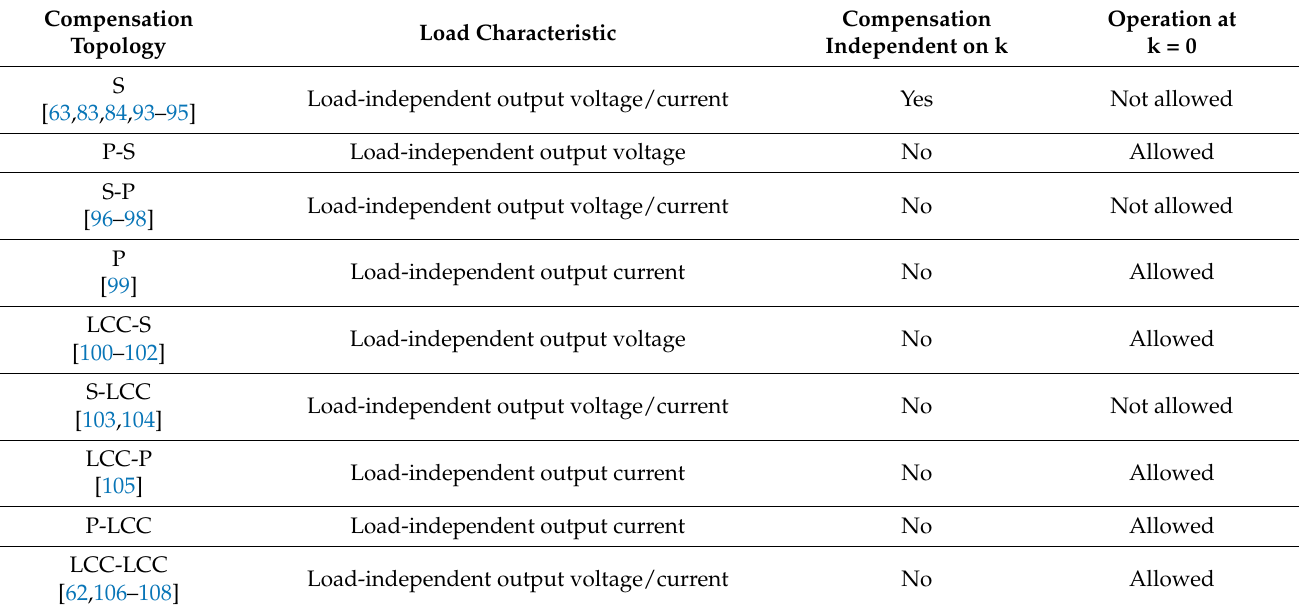
Table 4. Main characteristics of common compensation